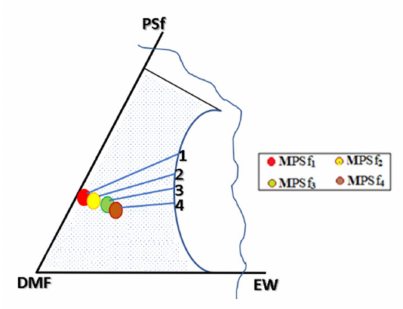
Figure 11. The schematic composition route of the polymeric film starting from the composition determined by the contact with the environment at times of 1 min (MPSf1), 3 min (MPSf2), 7 min (MPSf3), and 12 min